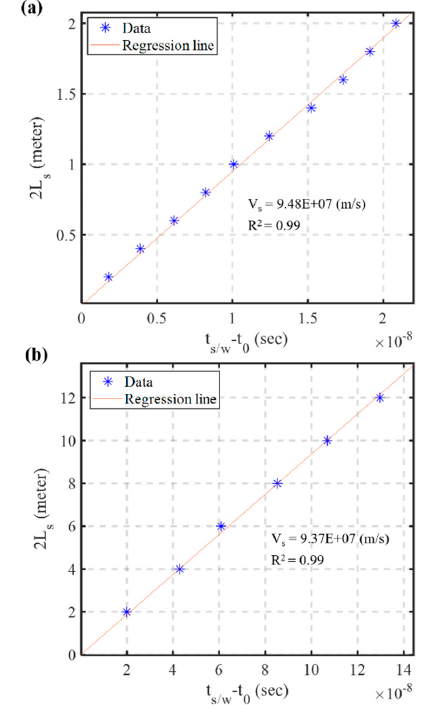
Figure 12. The relationship between 2 L s and round-trip travel time ( t s/w − t 0 ) in sediments from: the small-scale experiments ( a ); and the full-scale experiments ( b ).